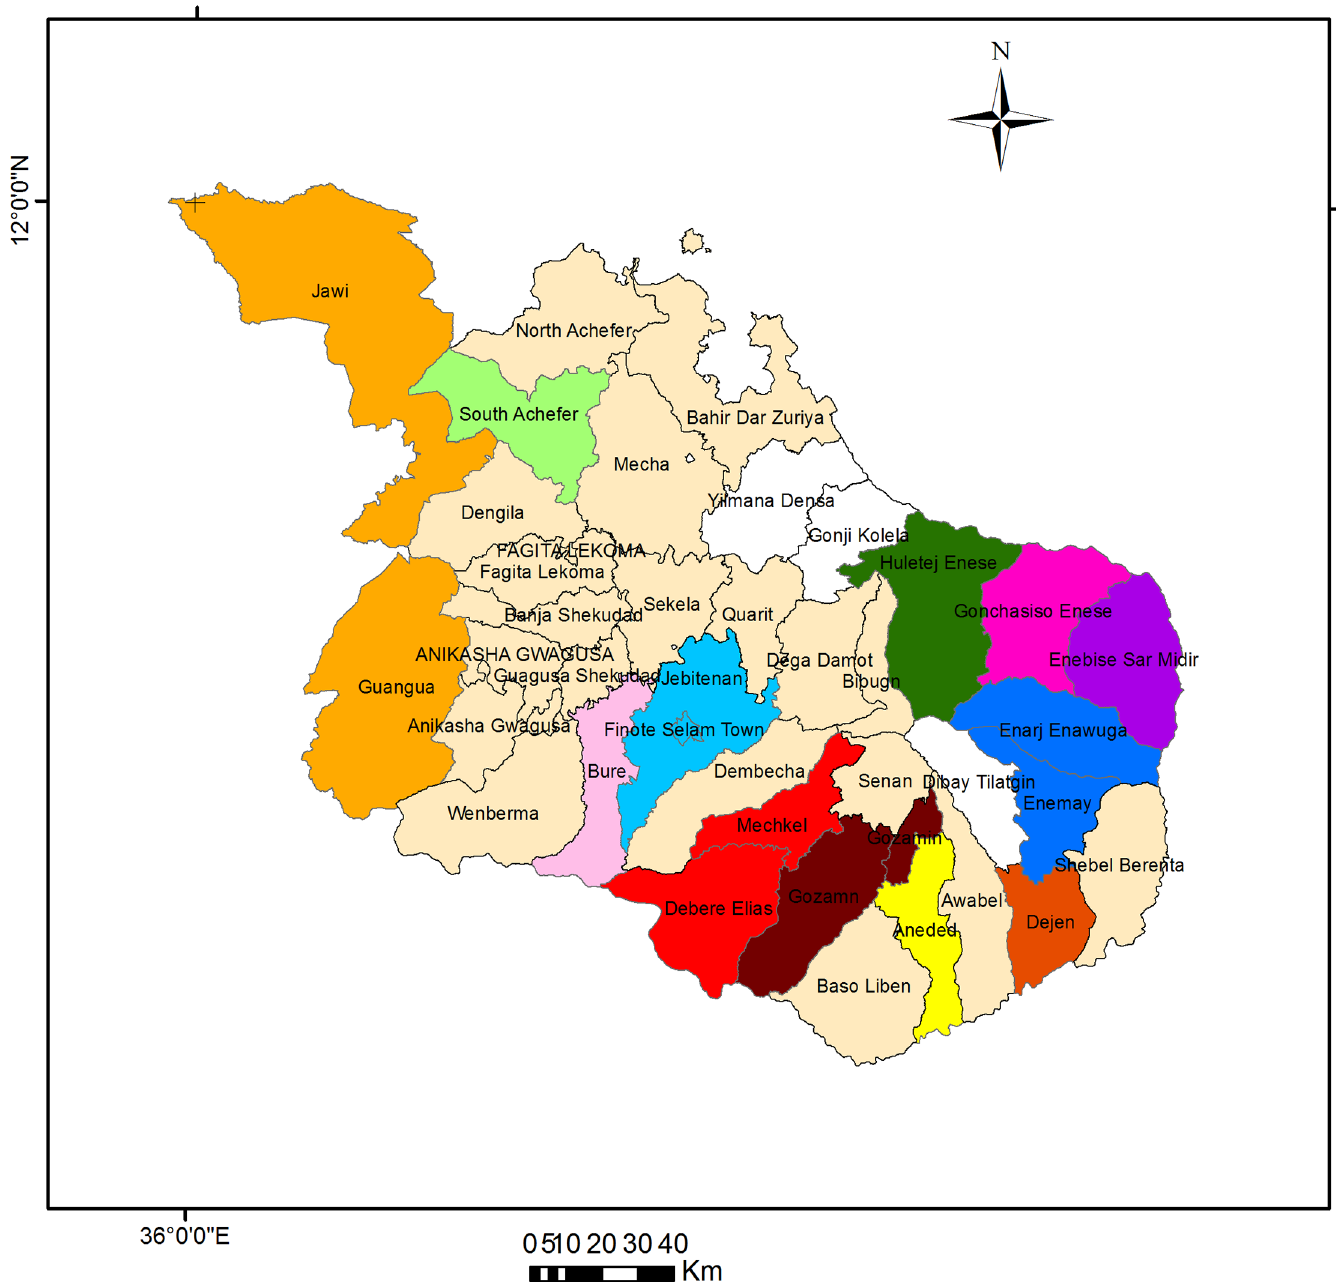
Fig 4. Most likely clusters (1) and secondary cluster (2, 3, 4, 5, 6, 7, 8, 9, 10, 11 and 12) of childhood diarrhea in northwest Ethiopia between 1 July 2007 and 30 June 2014. Numerical identification of the clusters are in order of their likelihood ratio; Dark red color indicates the cluster with the highest likelihood ratio and labeled cluster 1 (most likely cluster or primary cluster) while cluster 2 (light red color), cluster 3 (flame red color) and cluster 4 (green), cluster 5 (light blue), cluster 6 (dark blue), cluster 7 (violet), cluster 8 (pink), cluster 9 (light apple), cluster 10 (gold), cluster 11 (rose) and cluster 12 (yellow) are secondary clusters from the highest to lowest likelihood ratio. Beige color indicates none cluster districs. For more detailed cluster information, refer to Table